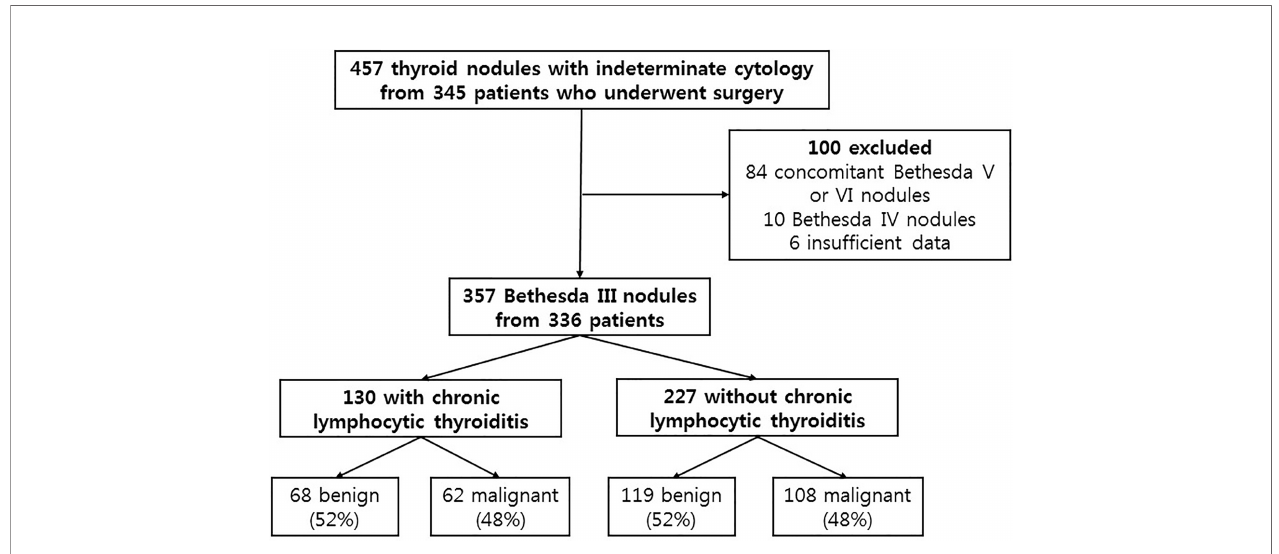
FIGURE 1 | Schematic presentation of the study